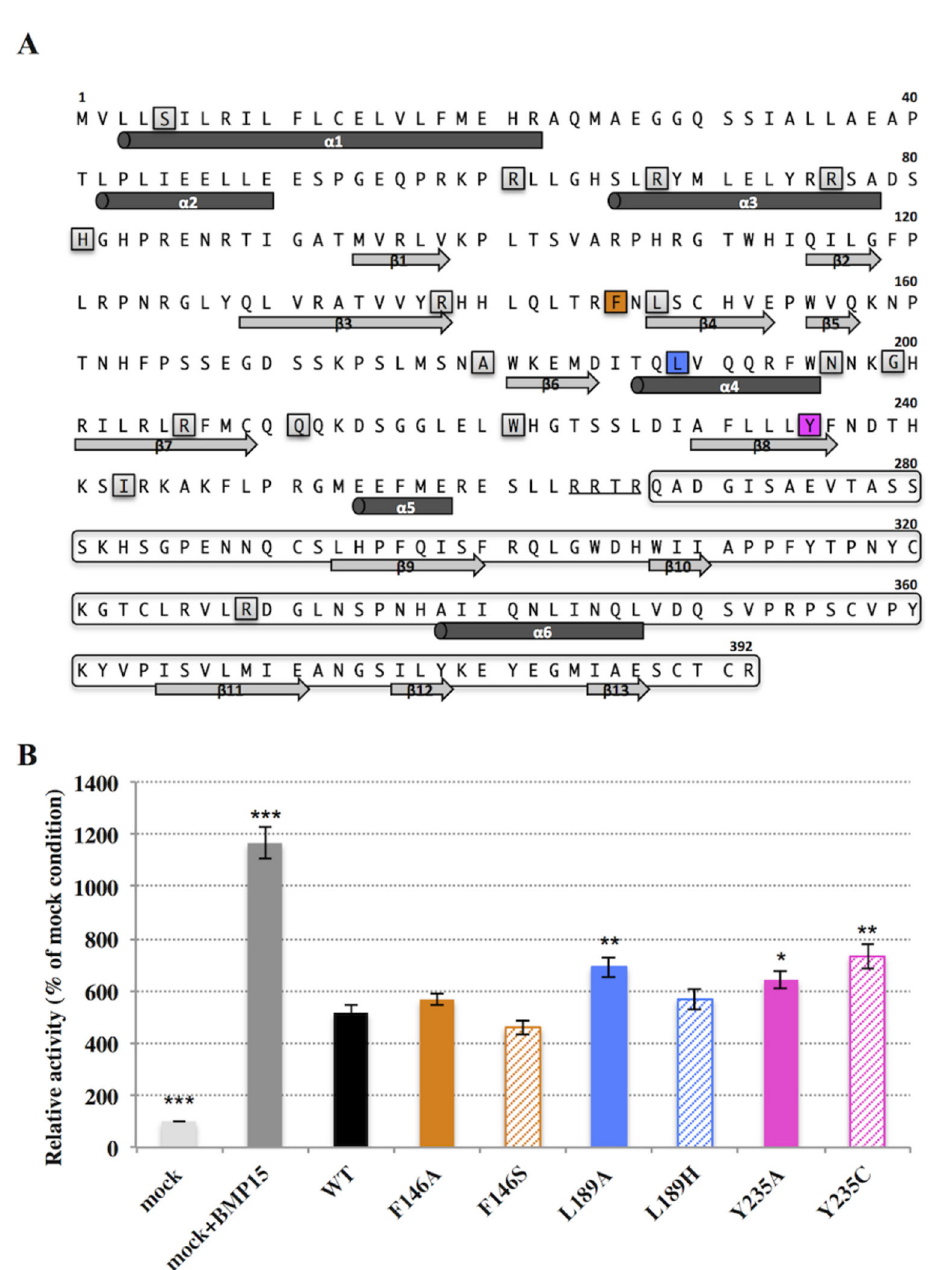
Figure 3. Functional analysis of amino acids under positive selection in human BMP15. A, Human BMP15 full sequence showing prodomain, cleavage site (underlined) and mature peptide (framed sequence); known human variants for BMP15 found in POI patients (framed grey highligthed); and identified amino acids under positive selection (framed colored highlighted): BMP15 F146 , BMP15 L189 , BMP15 Y235 . B, In vitro reporter luciferase assay from COV434 granulosa cells transiently transfected with empty vector +/- 100ng recombinant human BMP15 (mock +/- BMP15) or wild type human BMP15 expressing vector (WT) or the different BMP15 variants vectors obtained by directed-mutagenesis of residues under positive selection. Results are expressed as the mean (±SD) of 4 independent experiments. Differences between means were analyzed by one-way ANOVA by comparing each condition to WT (*, p<0.05; **, p<0;01; ***, p<0.001).